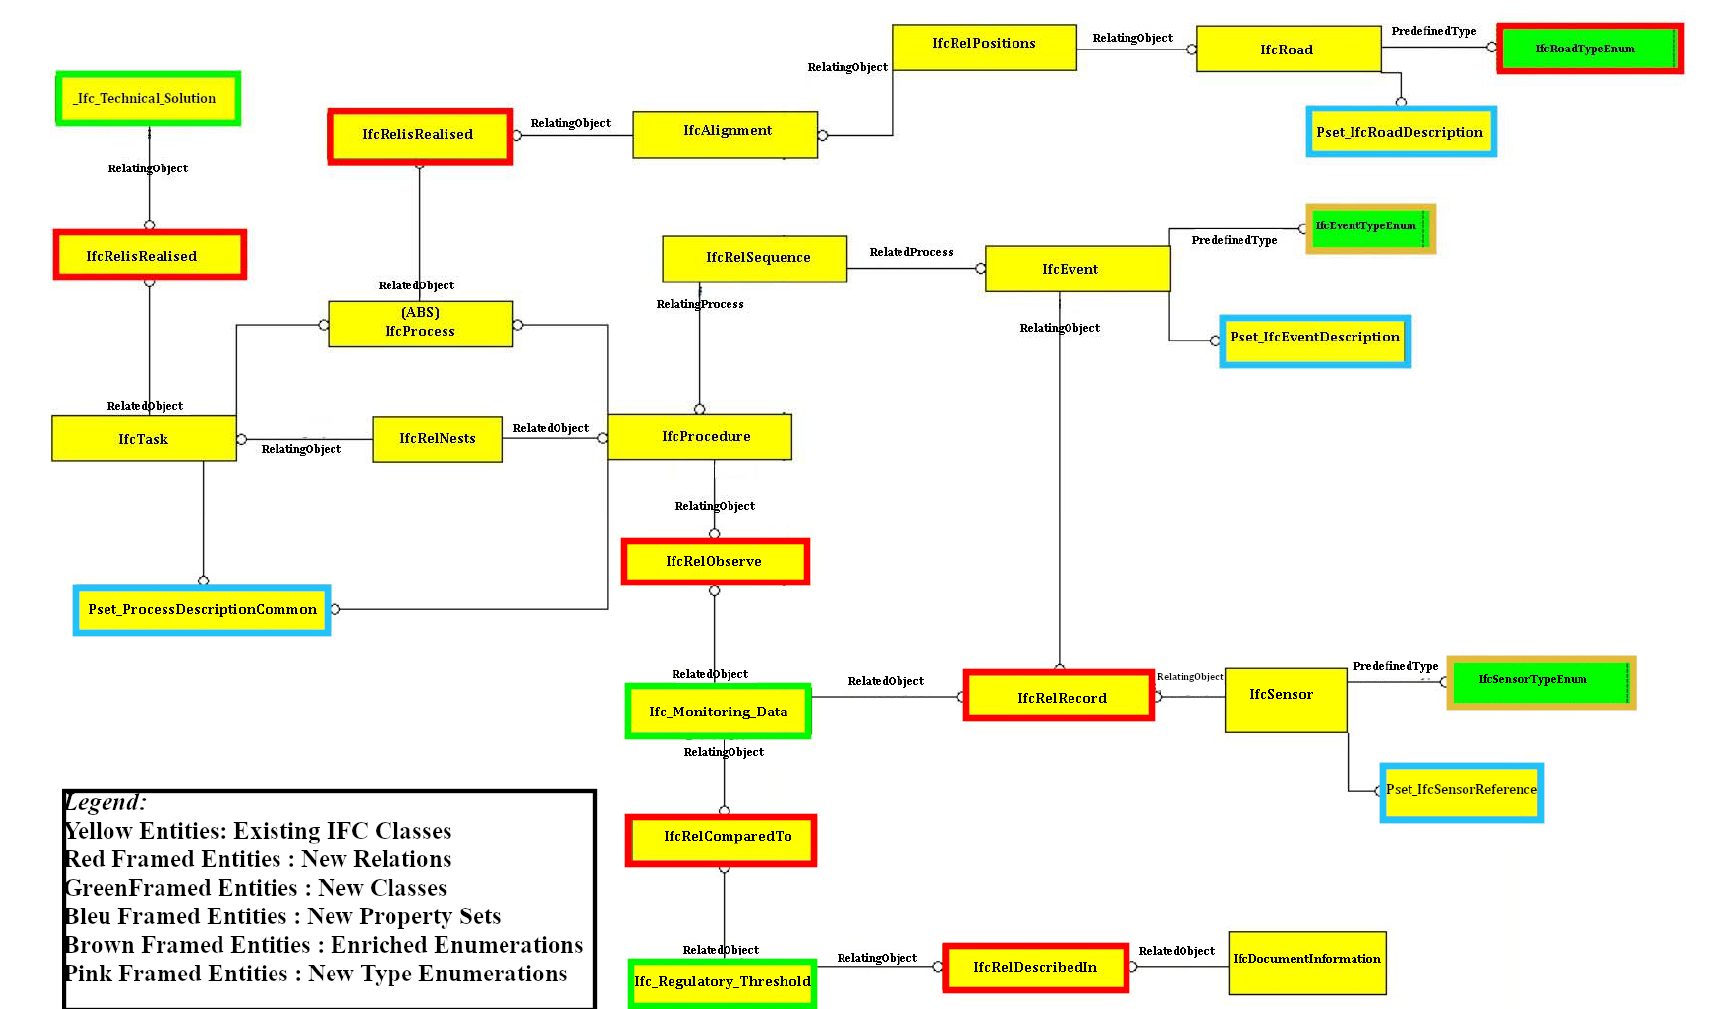
Figure 5. Extract from the EXPRESS diagram of the IFC extension by IFCInfra4OM ontology.